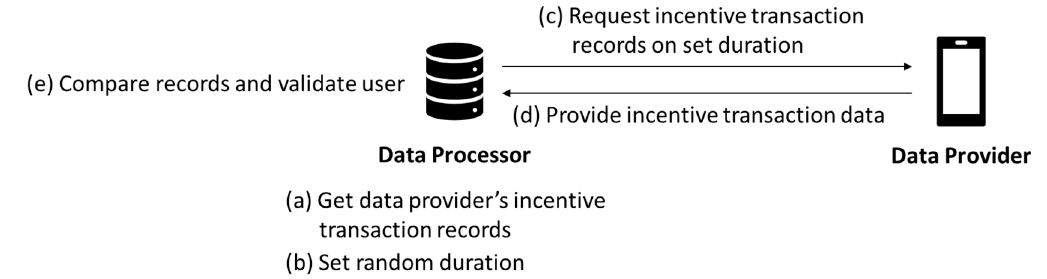
Figure 9. Incentive transaction-record based user verification.